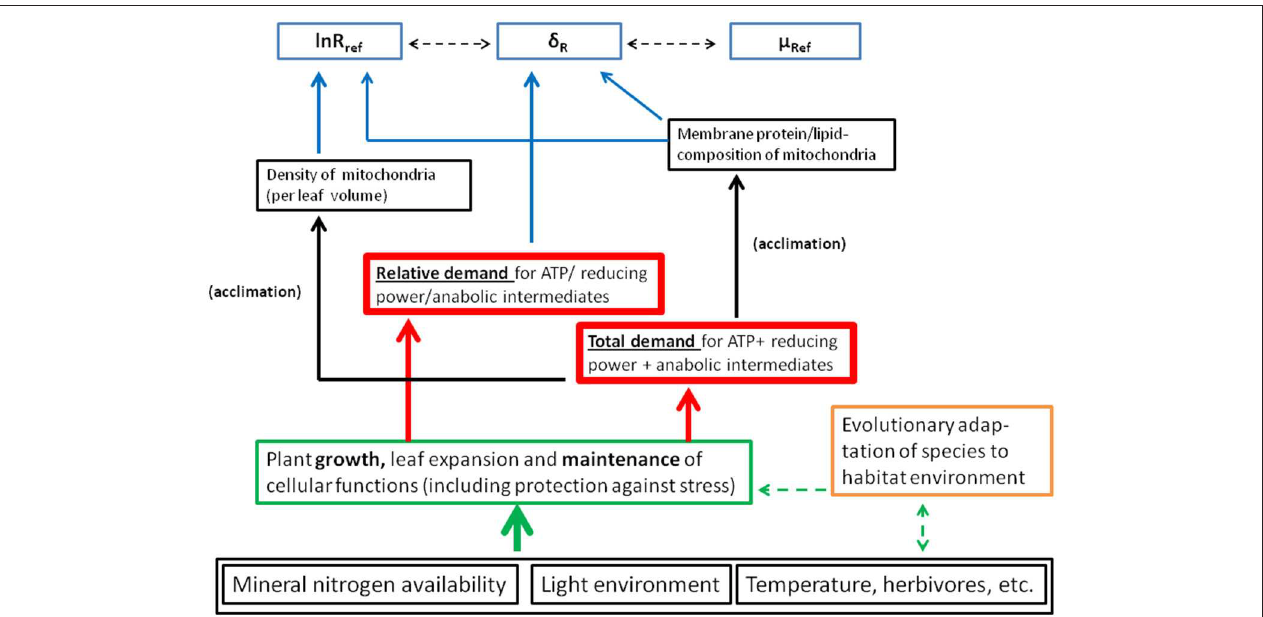
FIGURE 10 | Proposed causal relationships between measured respiration parameters and underlying physiology. Putative physiological causes for variation in the three respiration parameters lnR ref , µ Ref , and δ R are highlighted by blue arrows. Physiological/anatomical acclimation affects correlations between respiration parameters (as indicated by dashed, black arrows). Acclimation is driven by environmentally induced shifts in cellular demand for ATP, reducing power and anabolic intermediates—both in absolute and relative terms. We emphasized acclimation to absolute demand for energy and metabolites, met by adjustments of mitochondrial density and enzyme concentration per mitochondrion. Short-term shifts in relative demand for energy and metabolites may more efficiently be met by post-translational modifications of existing enzymes ( O’Leary and Plaxton, 2017). For a more detailed discussion see the